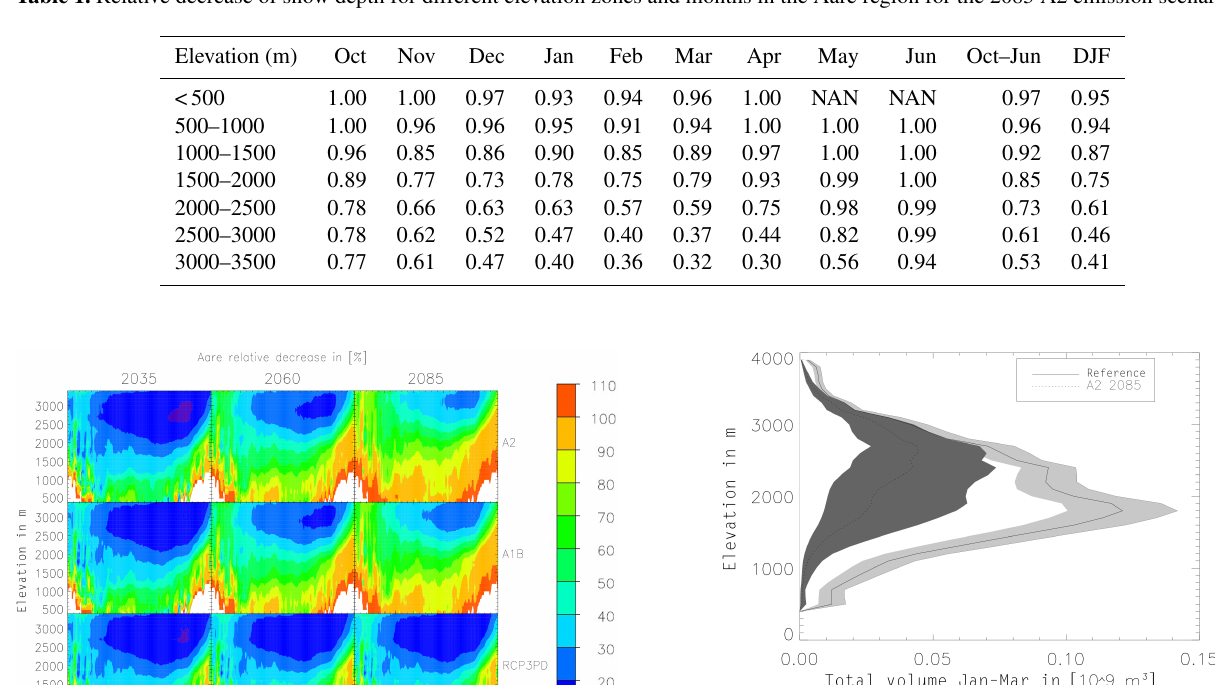
Table 1. Relative decrease of snow depth for different elevation zones and months in the Aare region for the 2085 A2 emission scenario.